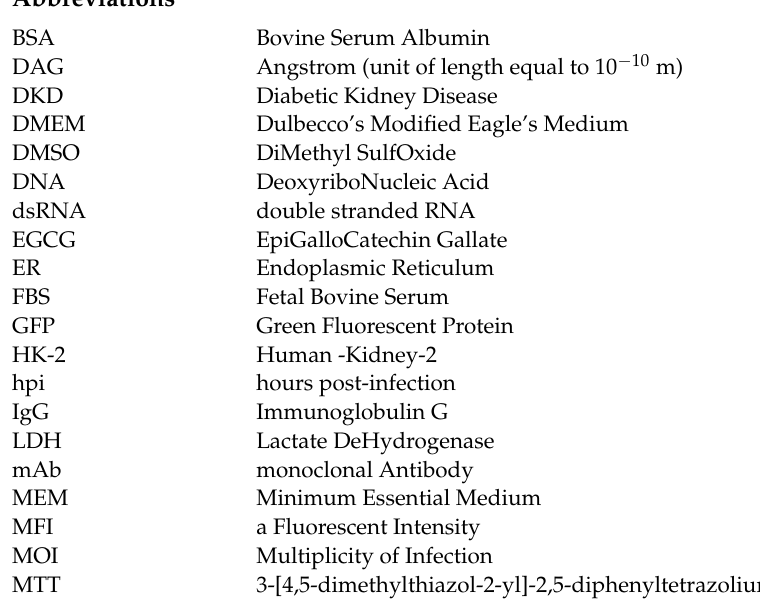
Figure S2. Osmolarity does not lead to ZIKV restriction in HK-2 cells; Figure S3. Protein translation in HK-2 cells is not affected under high glucose